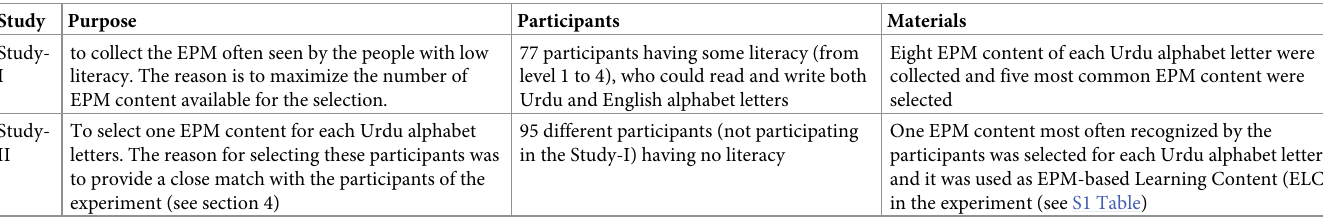
Table 3. Purpose, participants, and materials used in the ethnographic